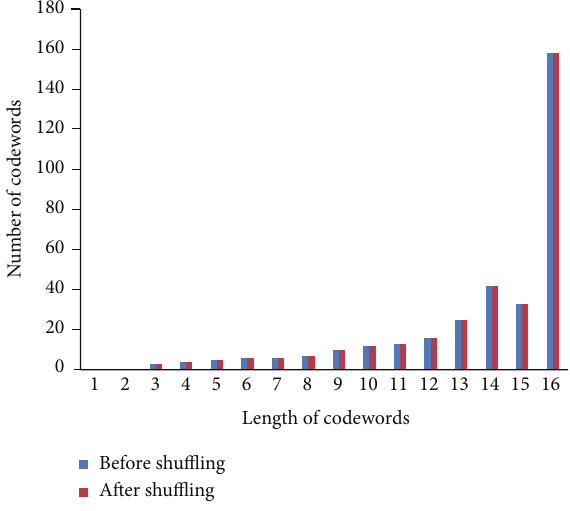
Figure 4: Effect of encryption on codeword